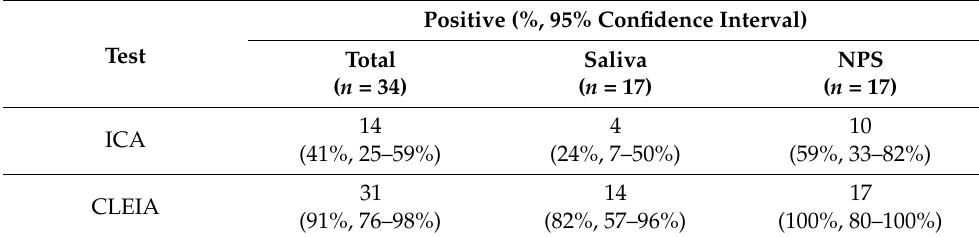
Table 1. Diagnostic results in positive specimens diagnosed by